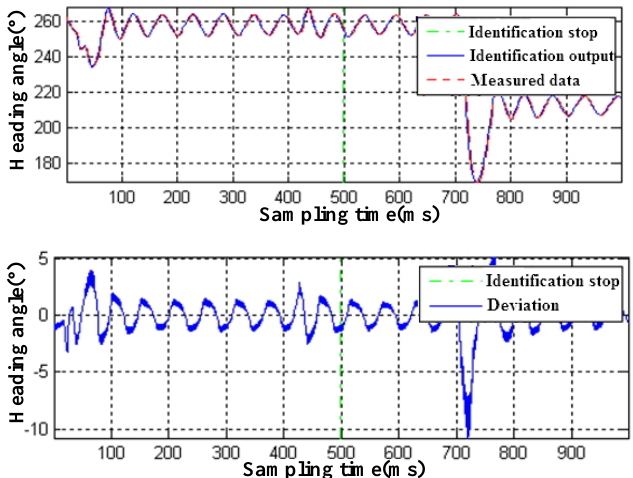
Figure 10. Identification results of heading control loop.